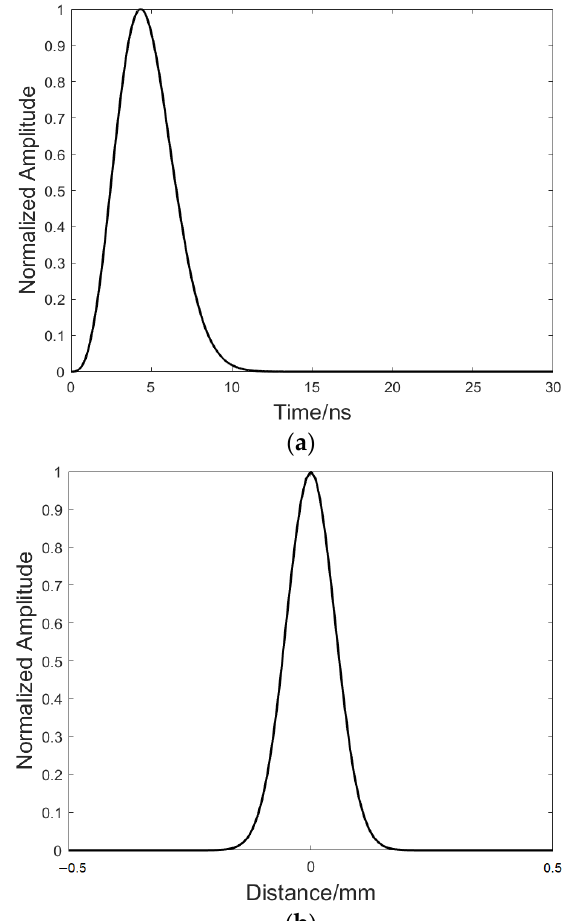
Figure 3. ( a ) Function in the time domain; ( b ) function in the spatial domain.